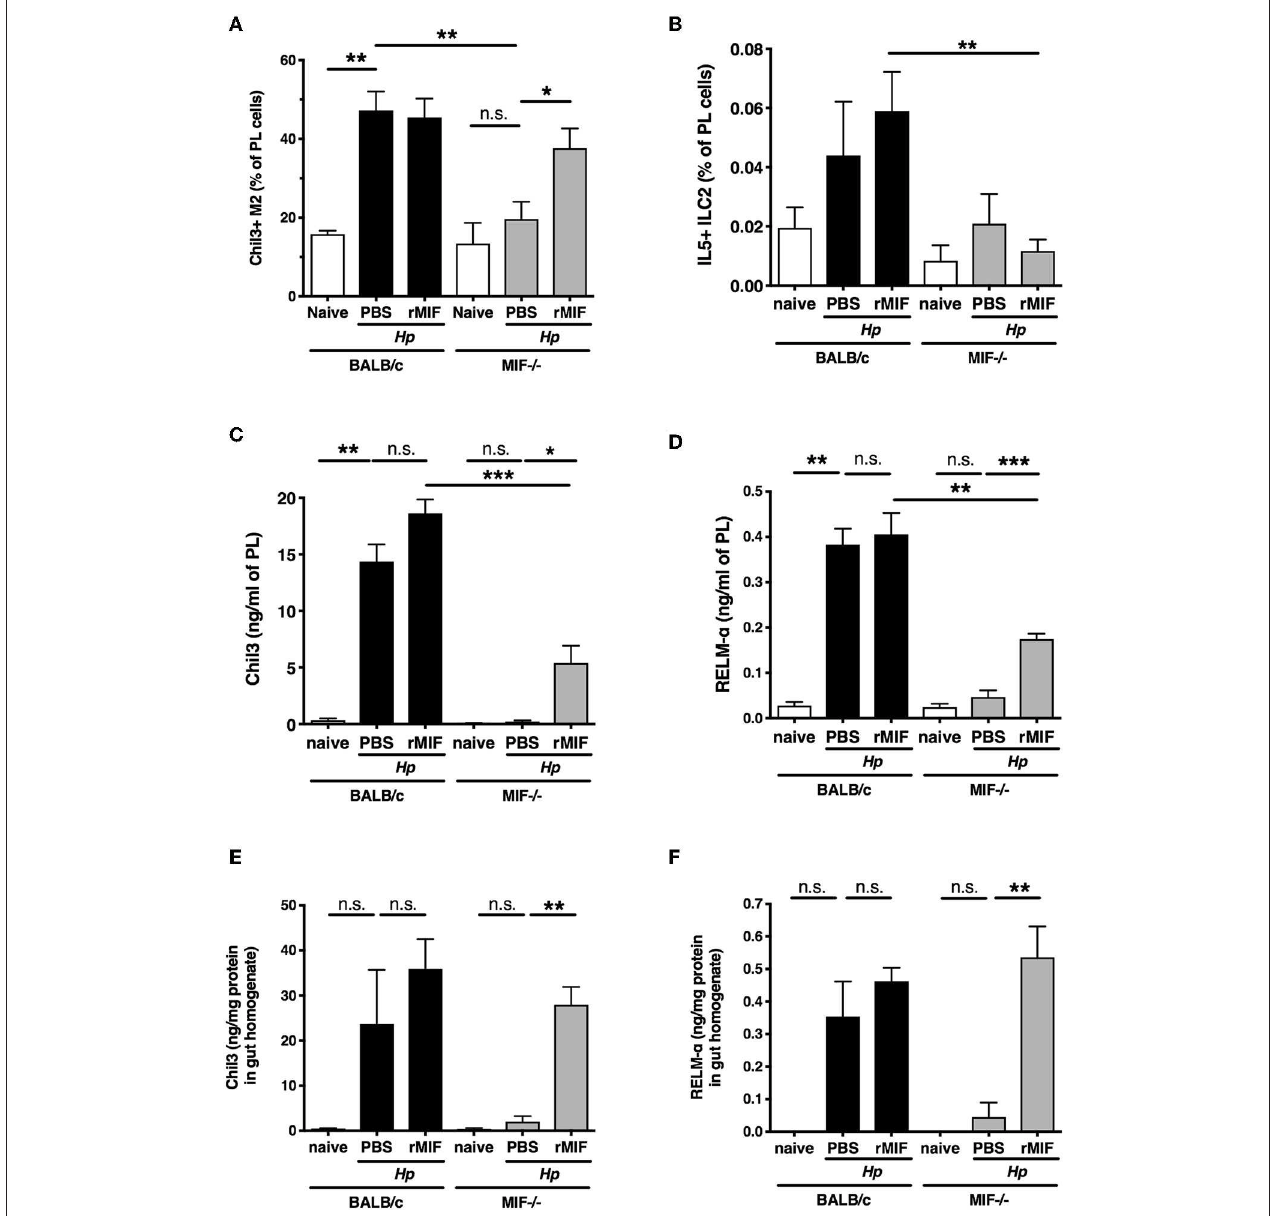
FIGURE 5 | rMIF rescues the macrophage phenotype of MIF-deficient mice. (A) Administration of recombinant MIF can rescue the MIF − / − phenotype after H. polygyrus infection. Percentage of peritoneal macrophages (CD11b + F4/80 + ) that are Chil3 + in BALB/c or MIF − / − mice treated with PBS or 50 µ g recombinant MIF intraperitoneally, at day 7 post-infection with H. polygyrus, or in naïve mice. Results are combined from two experiments with similar results. (B) Percentage of PL cells that are IL-5 + ILC2s from the same experiments as (A) . Results are combined from two experiments with similar results. (C,D) Expression of Chil3 (C) and RELM α (D) in peritoneal lavage fluid, measured by ELISA, from the same experiments as (A) . Results are combined from two experiments with similar results. (E,F) Expression of Chil3 (E) and RELM α (F) in small intestinal homogenate, measured by ELISA, from the same experiments as (A) . Results are combined from two experiments with similar results. n.s., not significant, * p < 0.05, ** p < 0.01, *** p <